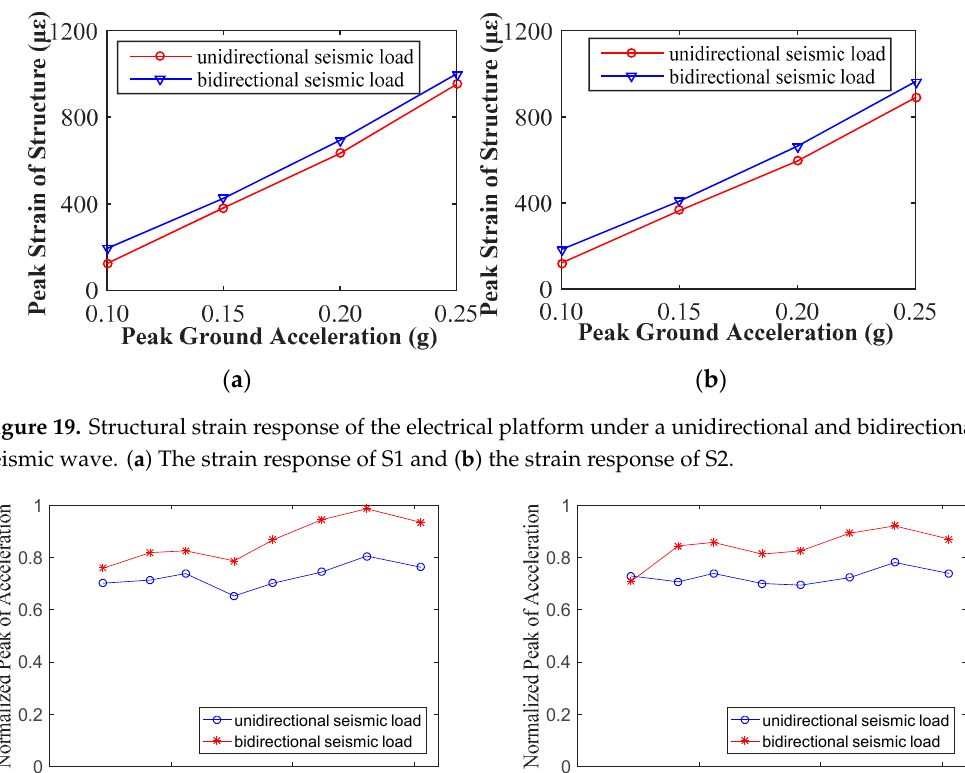
Figure 19. Structural strain response of the electrical platform under a unidirectional and bidirectional seismic wave. ( a ) The strain response of S1 and ( b ) the strain response of S2.